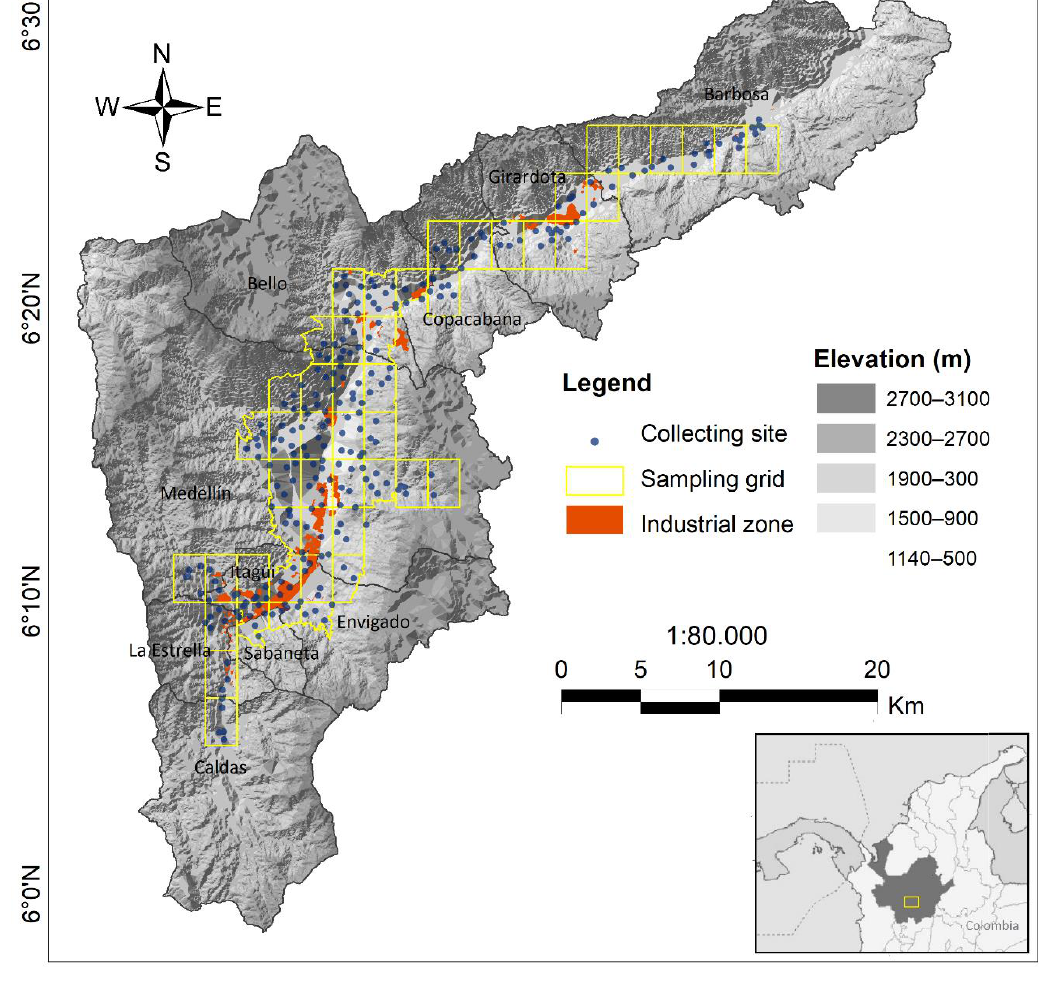
Figure 1. Study area and sampling sites in urban areas of Aburrá Valley (Colombia): Caldas, La Estrella, Sabaneta, Envigado, Itagüí, Medellin, Bello, Copacabana, Girardota and Barbosa.